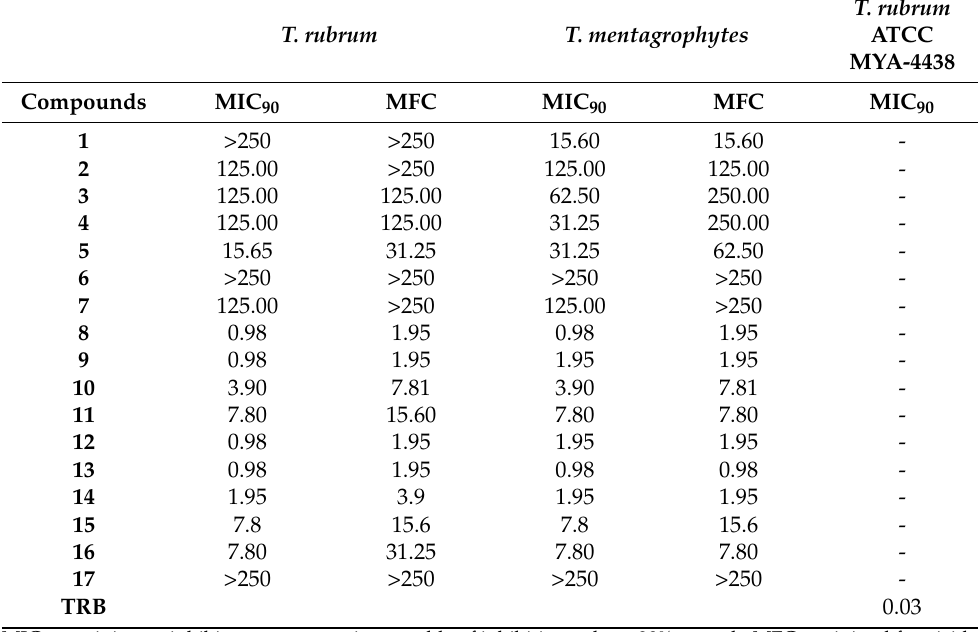
Table 3. Minimum inhibitory and fungicidal concentration values ( µ g/mL) of the 17 nitrofuran derivatives against